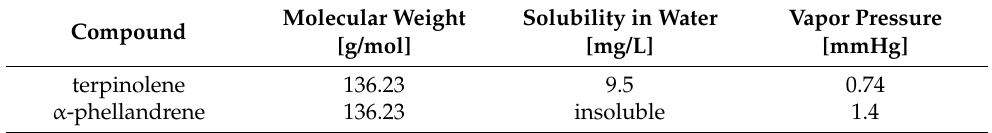
Table 1. Some chemical and physical properties of terpinolene and α -phellandrene 1 .